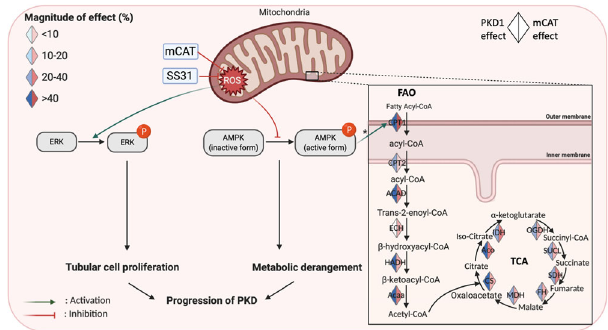
Fig. 9 Schematic illustration of the molecular mechanisms downstream of ROS in PKD1 mutant kidneys. Mitochondrial ROS induce activation/ phosphorylation of ERK, inhibition of AMPK, and the subsequent decreases (indicated by blue) in most enzymes involved in the fatty acid oxidation (FAO) and tricarboxylic acid (TCA) cycle. These enzymes were increased (indicated by red) by mCAT treatment of PKD1 mutant mice, suggesting a partial restoration of FAO and TCA, * through inhibition of acyl-CoA